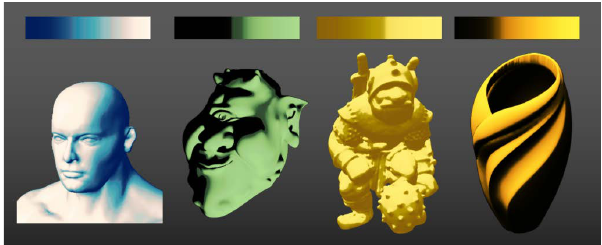
Fig. 1 Stylized shading styles obtained by color map